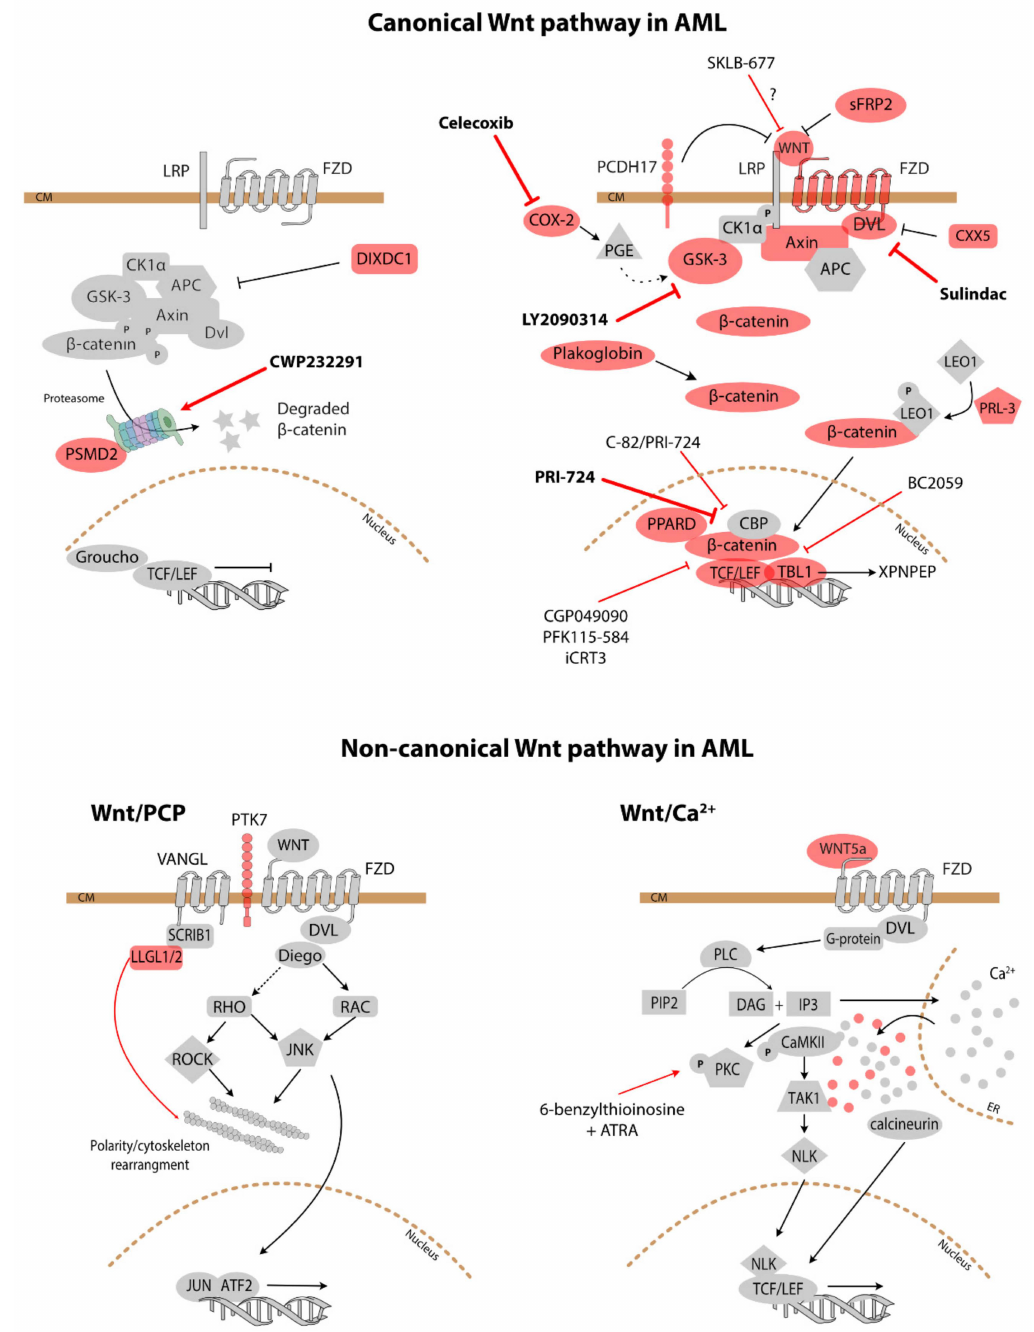
Figure 3. Wnt signalling in AML. The proteins in coral red have been specifically implicated in AML. Thin red bar-headed arrows indicate where investigational inhibitors act, while thick red bar-headed arrows show the targets of agents used in clinical trials. ER—endoplasmic